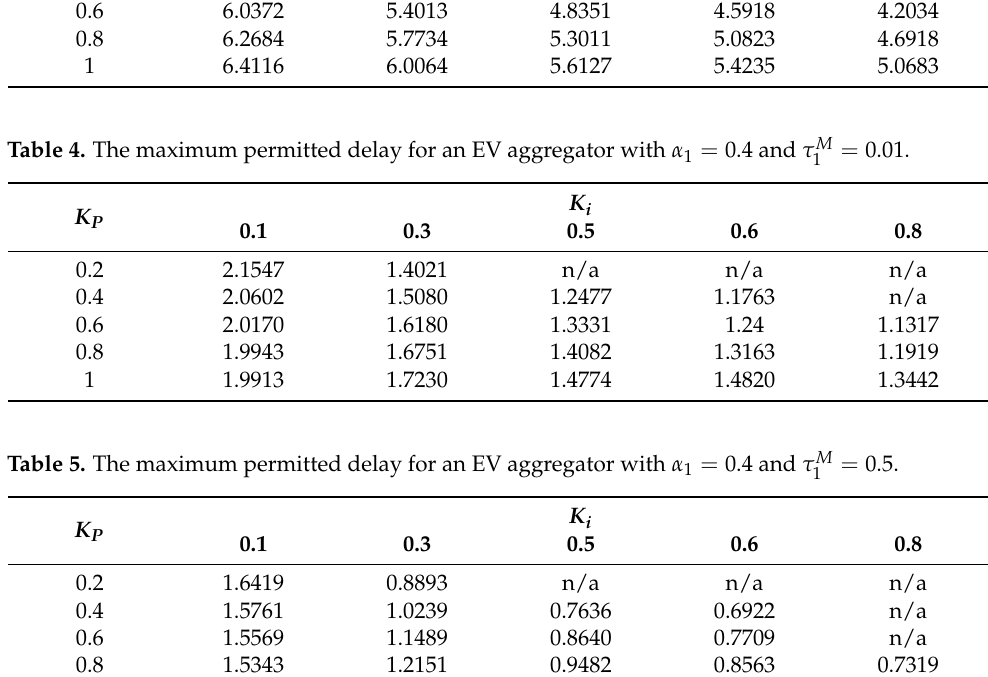
Table 4. The maximum permitted delay for an EV aggregator with α 1 = 0.4 and τ M